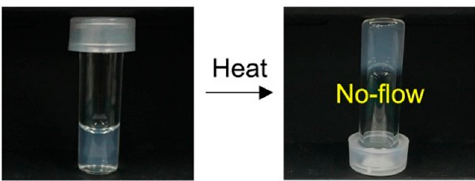
Figure 3. The sol and the gel states of the aqueous laponite/PEG-PLGA nanocomposite with 0.75 wt % of laponite and 3.0 wt % of PEG1.0k–PLGA1.6k.